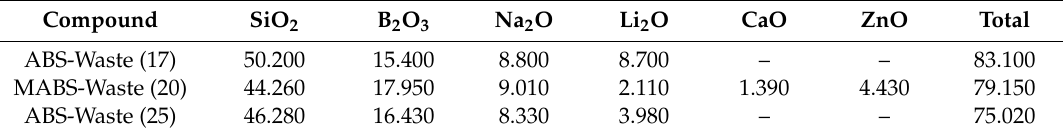
Table 2. Chemical composition of the studied glasses (structural elements and